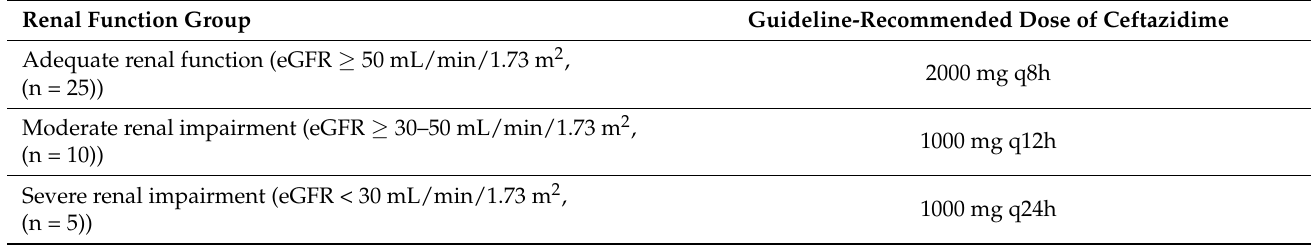
Table 1. Guideline-recommended dose of ceftazidime.